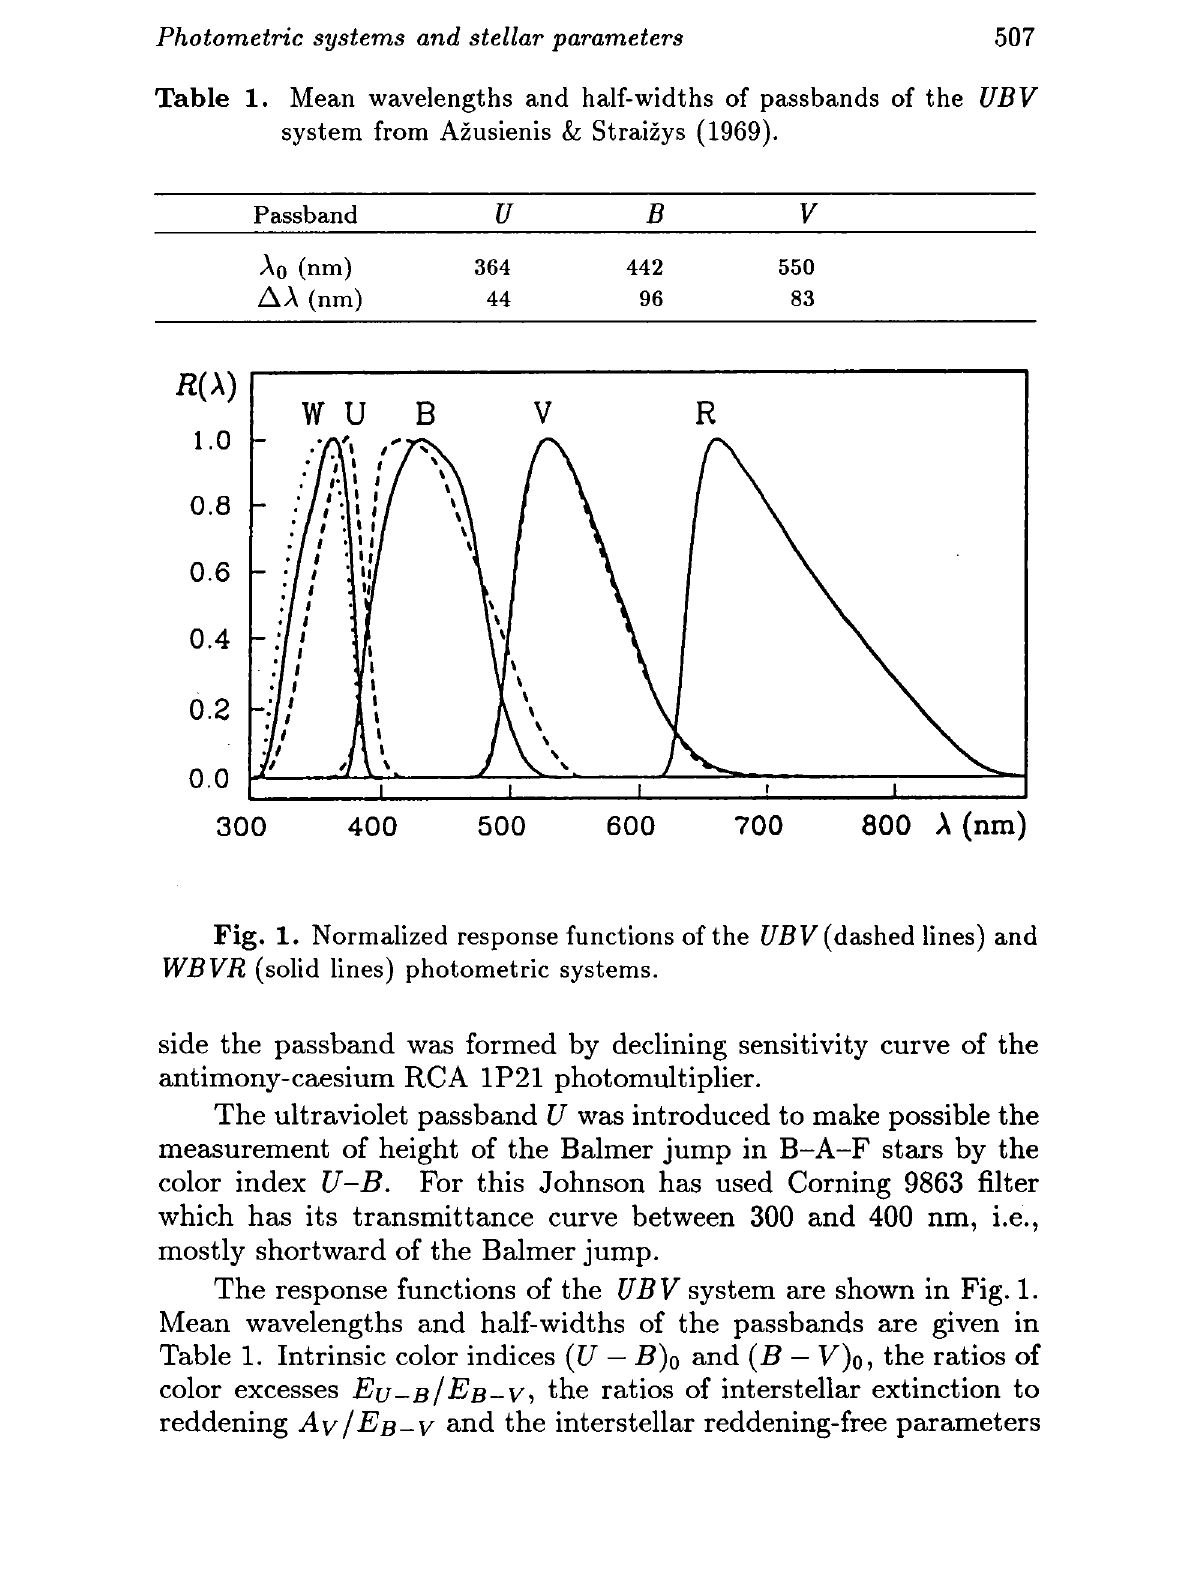
Table 1. Mean wavelengths and half-widths of passbands of the UBV system from Azusienis & Straizys (1969).